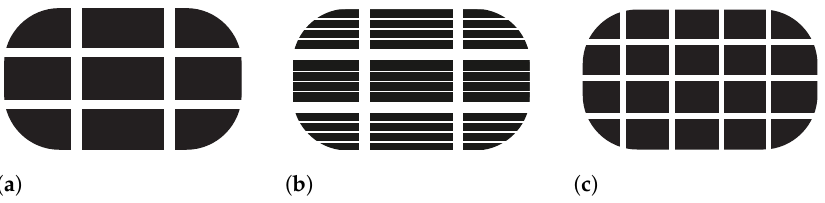
Figure 1. Schematic representation of the pattern geometries For detailed information see Appendix A. The direction of travel is vertical. ( a ) Big blocks (BB). ( b ) Big blocks with sipes (BBs). ( c ) Small blocks